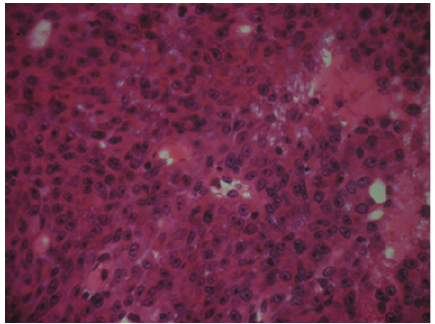
Figure 5: Esophageal tumor—sheets of large cells with plasmacy- toid features (HE ×